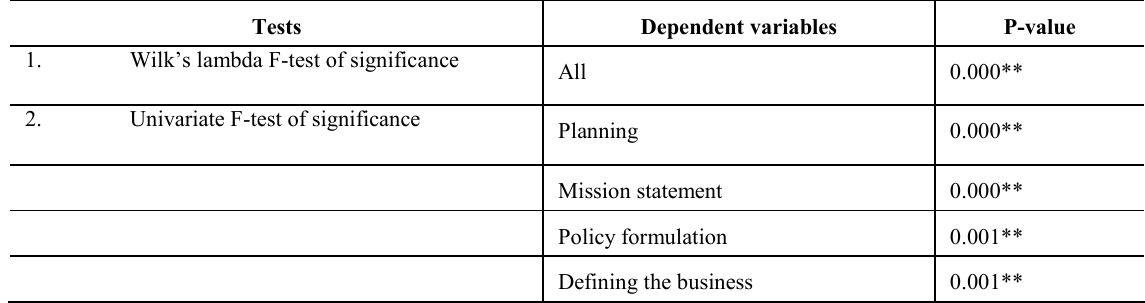
Table 3: The results of the tests to investigate relationships between task culture and strategy